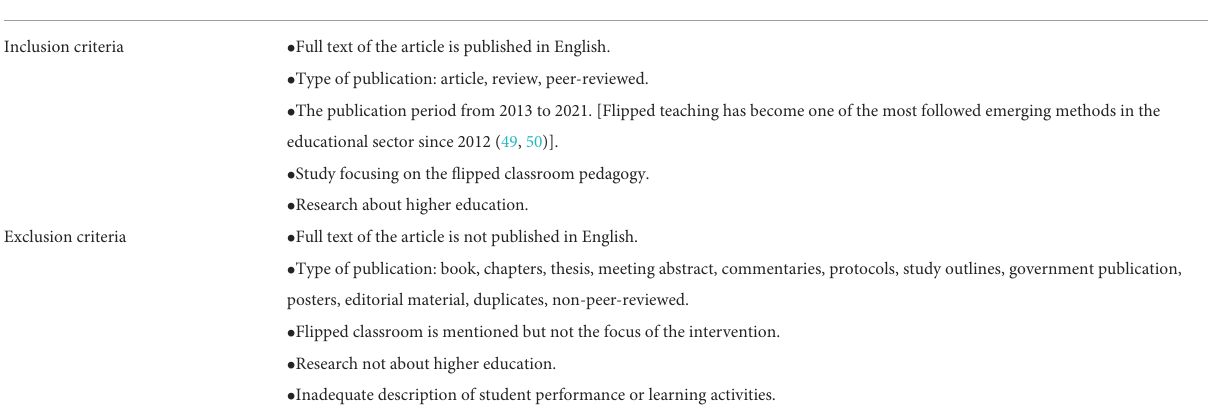
TABLE 1 Literature inclusion and exclusion